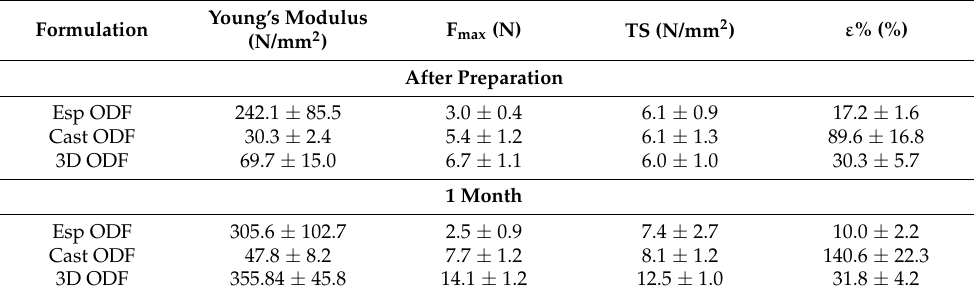
Table 4. Mechanical properties of ODFs ( n =